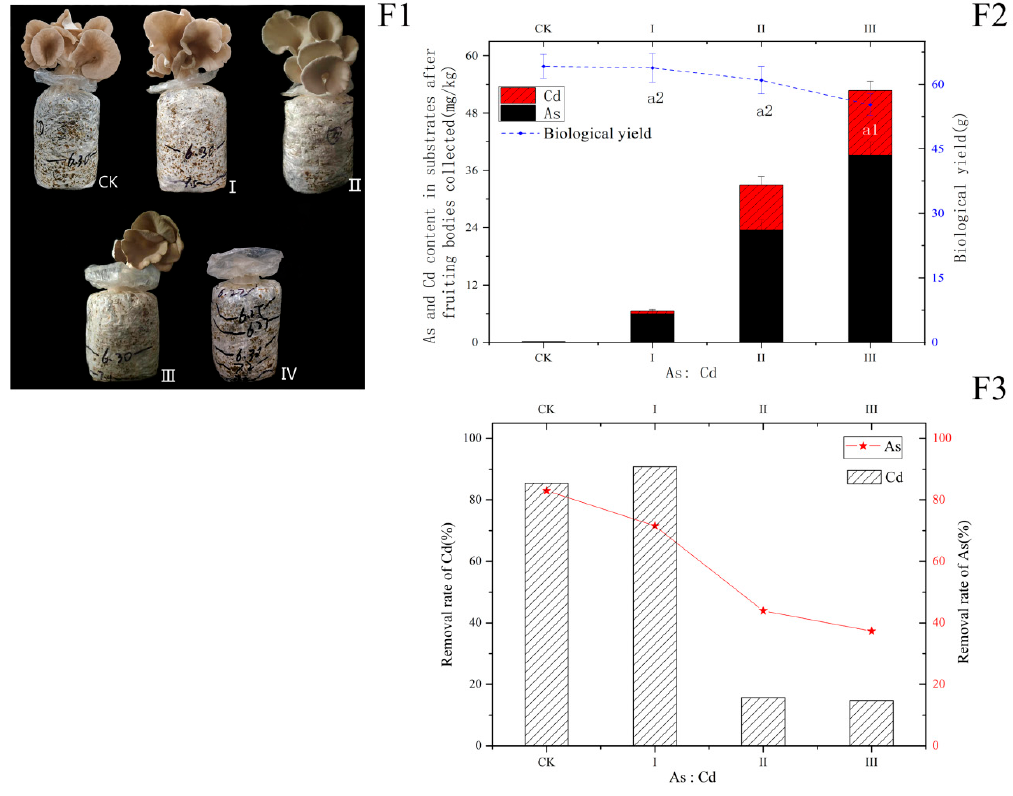
Figure 4. Simulation application in decontamination of soil containing As(III) and Cd(II) by the fruiting bodies of P. pulmonarius MT. ( F1 ) The growth of fruiting bodies under Cd and As stress;